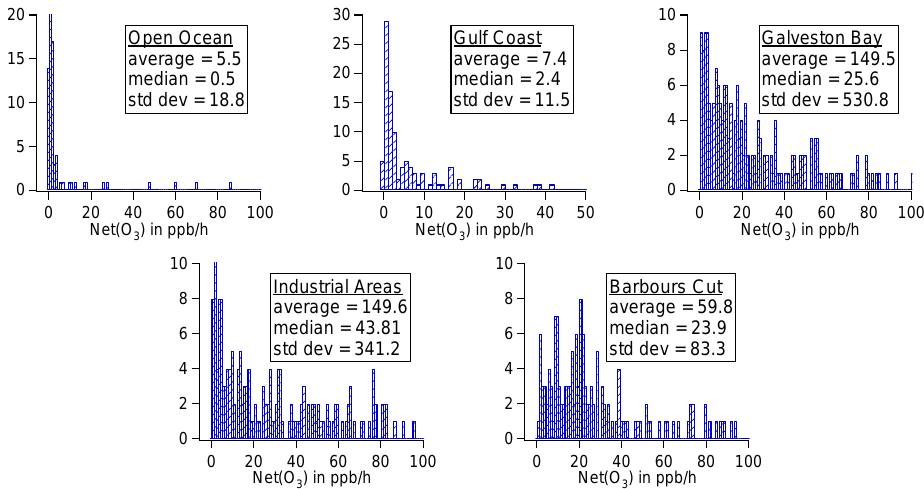
Fig. 9. Frequency distributions of Net( O 3 ) at different locations during the R/V Brown cruise. The bin size is 0.1 ppb / h for Open Ocean and 1 ppb / h for all the other locations. The values on the y -axis are the number of data points in each bin.